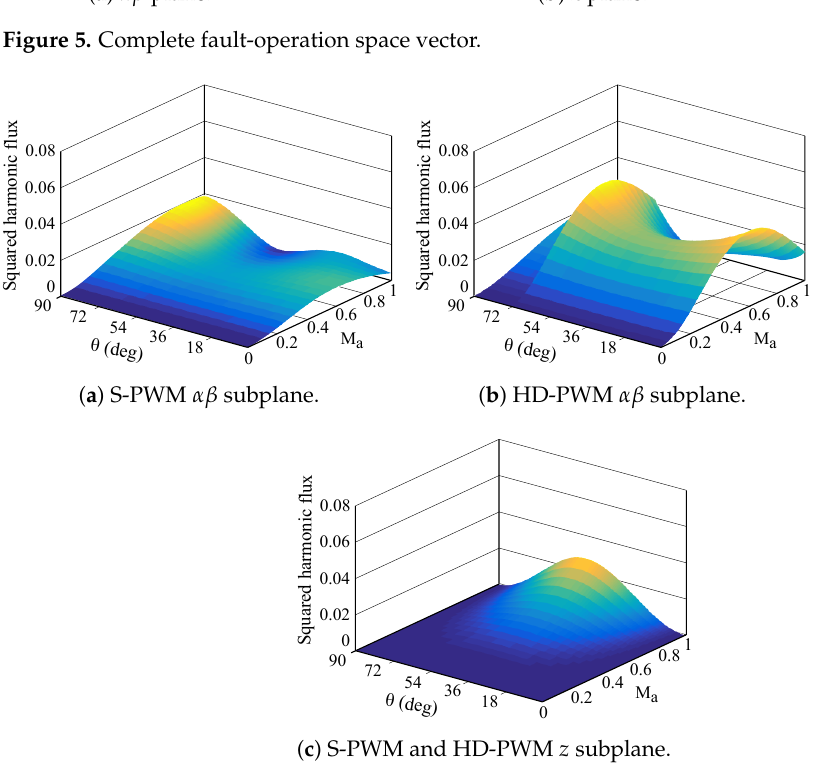
Figure 6. Squared harmonic flux of studied modulation techniques for θ ∈ [ 0, π / 2 ]